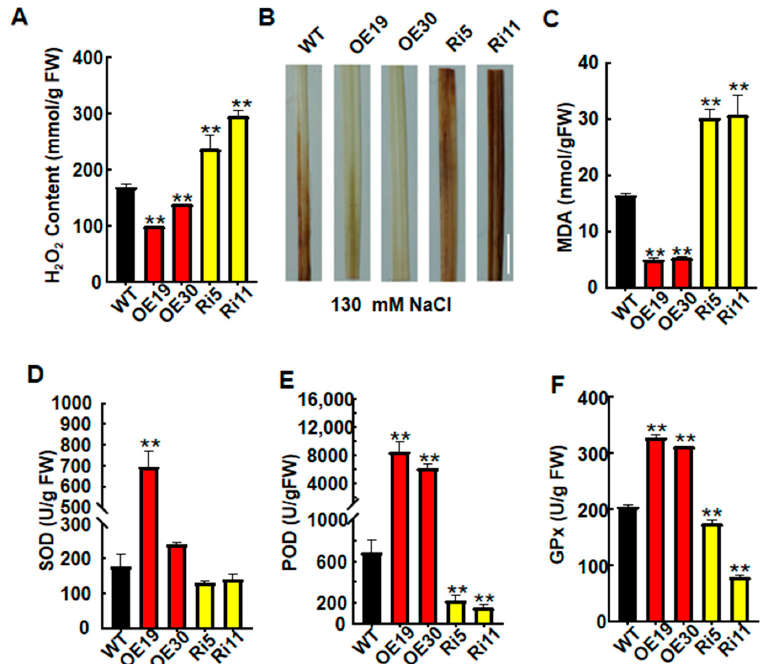
Figure 5. Analysis of physiological indexes in WT and OsASR6 transgenic plants under salt treatment. ( A ) H 2 O 2 content, ( B ) DAB staining, (bar = 1 cm), ( C ) the MDA content, and ( D ) SOD, ( E ) POD and ( F ) GPx enzyme activity. Asterisks indicate significant differences between means of WT and transgenic lines. Three independent experiments were carried out with similar results. Data represent means ± SD. ** p < 0.01.